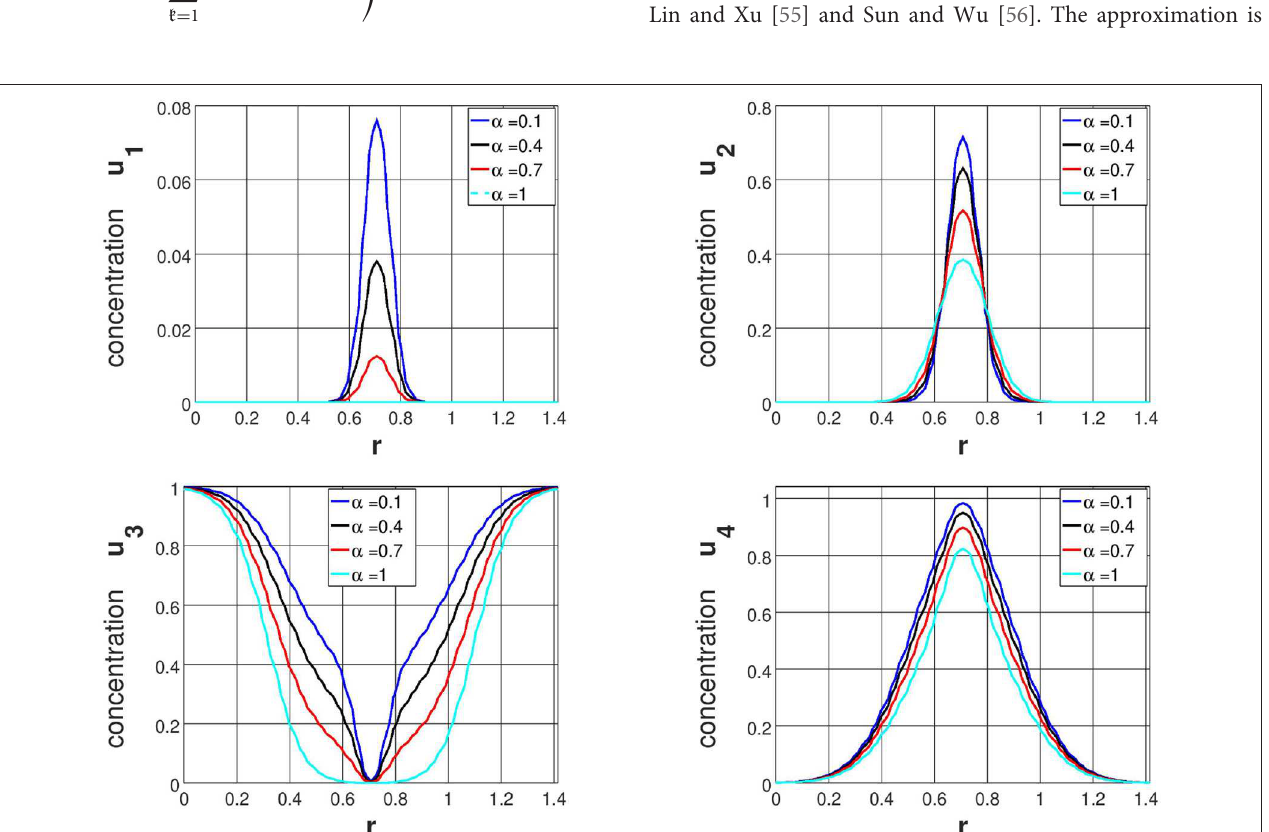
FIGURE 3 | Evaluation of u 1 , u 2 , u 3 , and u 4 at t = 5 along the line y = x .